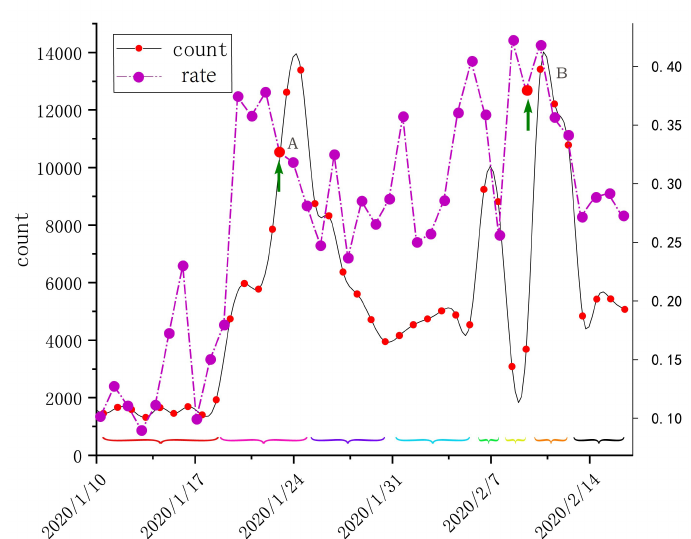
Figure 4. Weibo discussion distribution and emotional change (time A represents the closure of Wuhan, time B represents the start of the full suspected patient intake